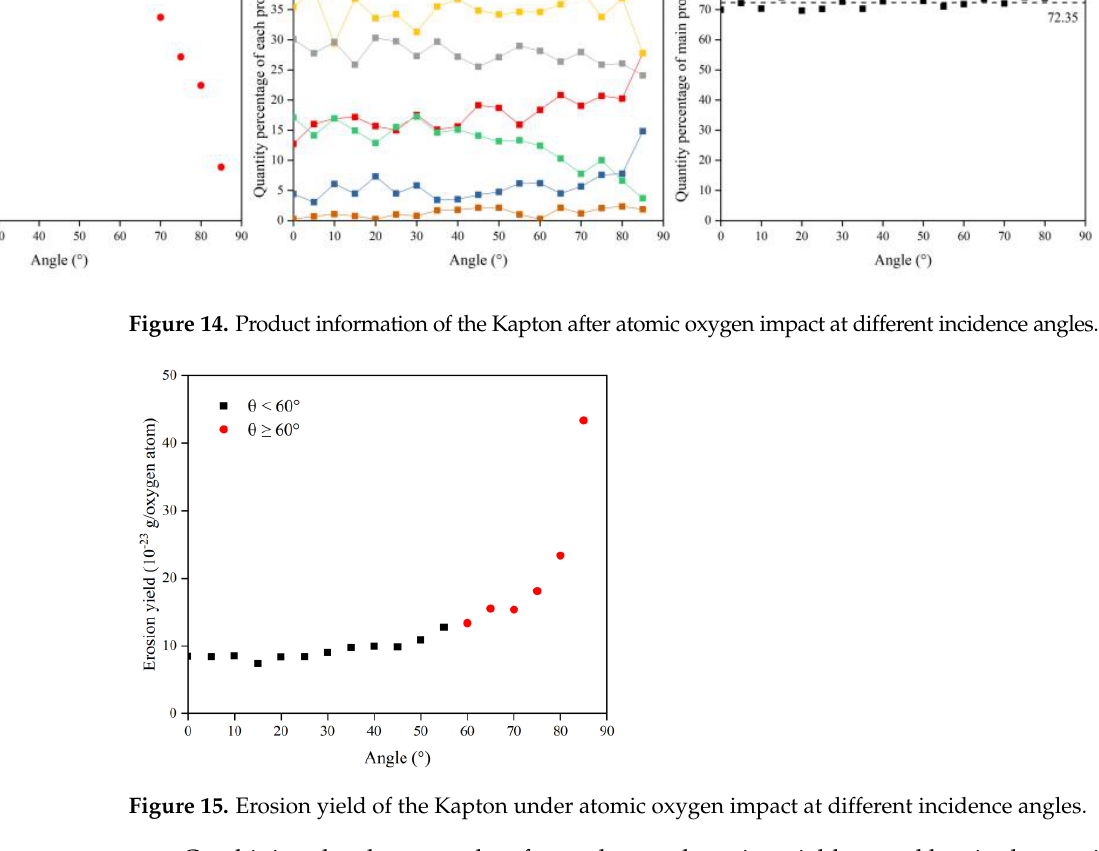
Figure 15. Erosion yield of the Kapton under atomic oxygen impact at different incidence angles.